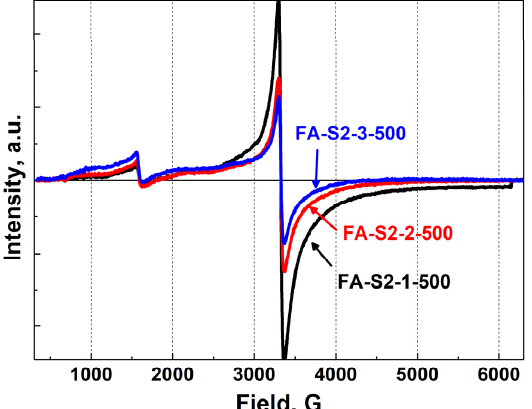
Figure 11. EPR spectra of samples FA-S2-1-500 (black line), FA-S2-2-500 (red line) and FA-S2-3-500 (blue line) at RT.